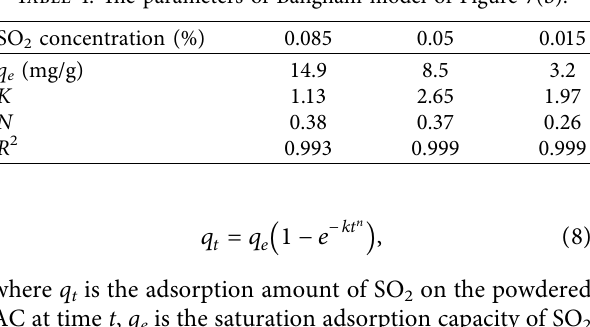
Table 4: The parameters of Bangham model of Figure